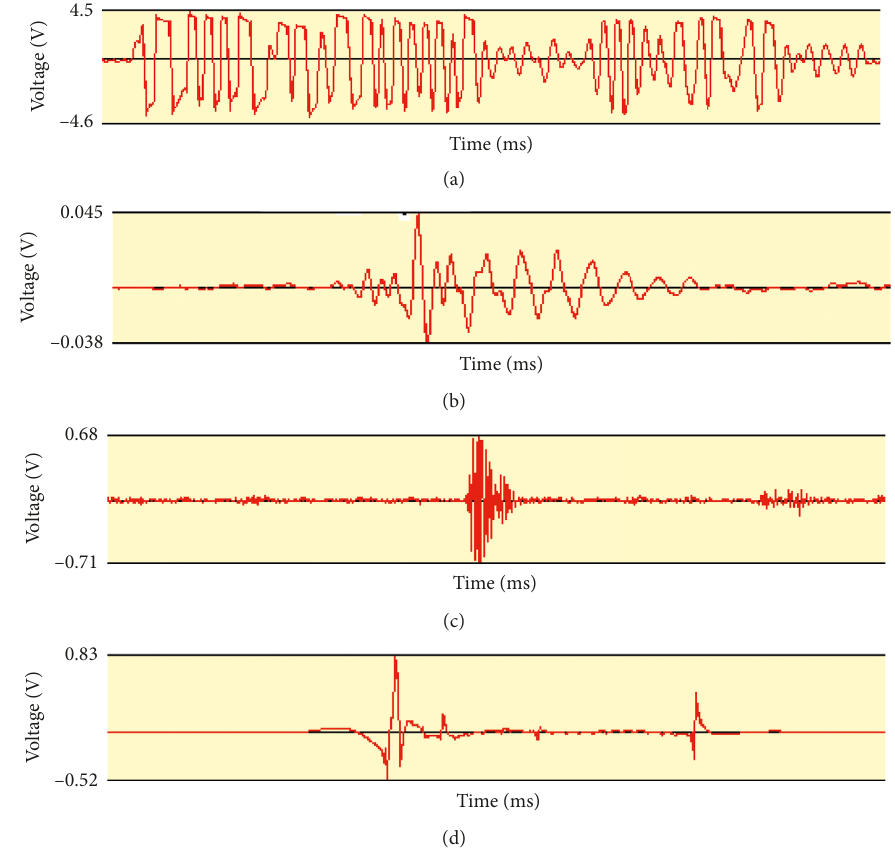
Figure 3: Various event waveforms. (a) Blast event waveform, (b) microseismic event waveform, (c) large machine impact tunnel waveform, and (d) electrical current interference